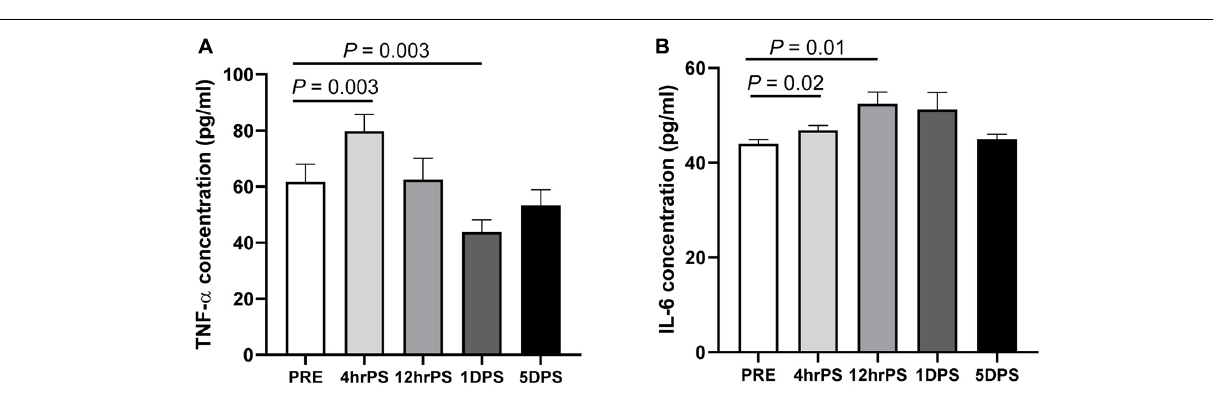
FIGURE 2 | Plasma concentrations of proinflammatory cytokines were increased during the acute stage of ischemic stroke in pigs. Plasma concentration (pg/ml) of (A) tumor necrosis factor alpha (TNF- α ) and (B) interleukin-6 (IL-6) were measured prestroke (PRE, n = 7), 4 h poststroke (4 hrPS, n = 7 and 6, respectively), 12